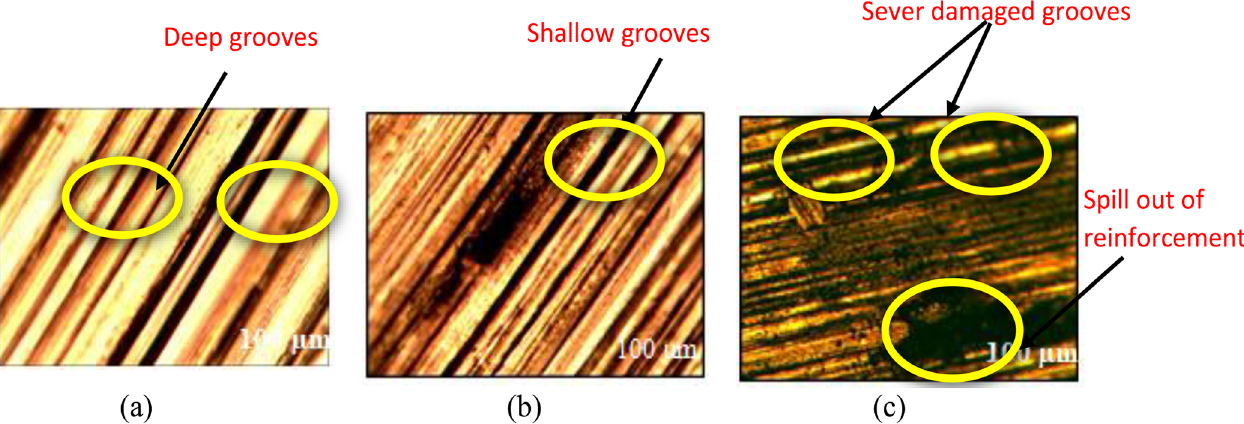
Fig. 17. Optical micrographs of worn surface of S3 and S4 samples. (a) S2 at 45 N, 300rpm; (b) S3 at 45 N, 300 rpm; (c) S4 at 45 N, 300 rpm.